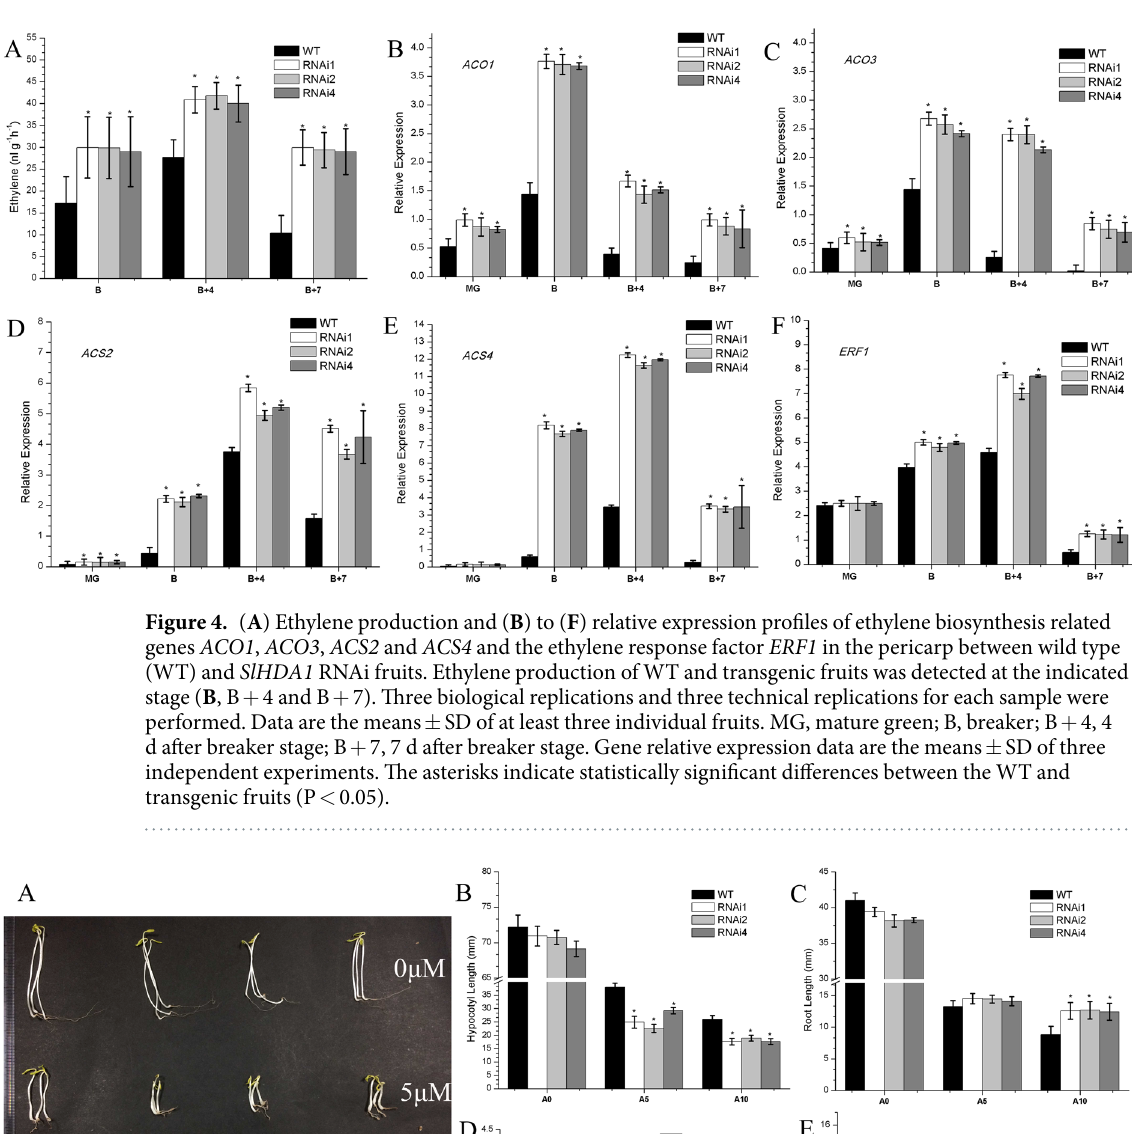
downstream carotenoids 25, 31 . A mutation in PSY1 causes a yellow-fresh phenotype and an absence of carotenoids in ripe fruit 32, 33 . Furthermore, the cyclization of lycopene is an important branching point in the pathway: one route leads to the production of β -carotene and its derivative xanthophylls (catalyze by LCY-B and CYC-B), whereas the other leads to α -carotene and lutein production (catalyze by LCY-B and LCY-E) 34 . The relative ratio of lycopene and β -carotene in ripening tomato fruit is mediated by up-regulation of PSY1 and down-regulation of